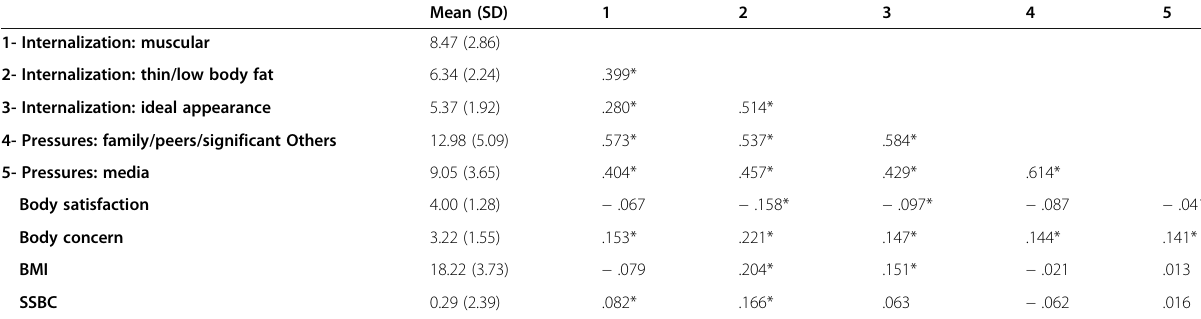
Table 8 Intercorrelations between SATAQ-4R-Male subscales, body satisfaction, body concern, BMI, and SSBC in Brazilian boys Mean